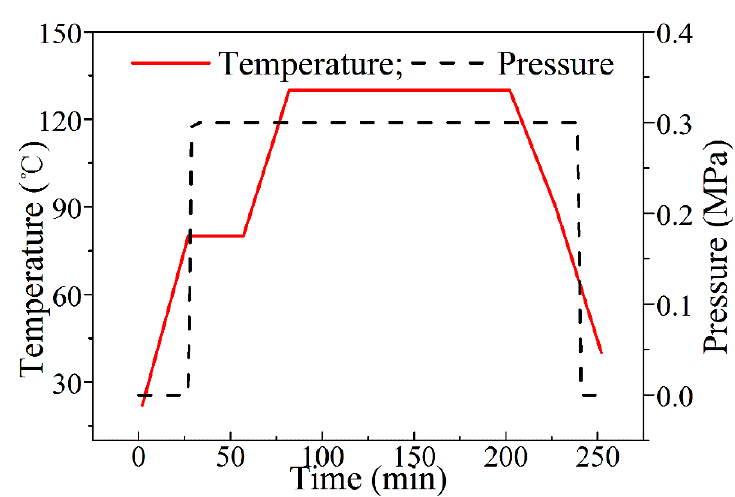
Figure 1. Curing cycle adopted for curing of carbon fiber-reinforced polymer (CFRP) laminates in an autoclave.